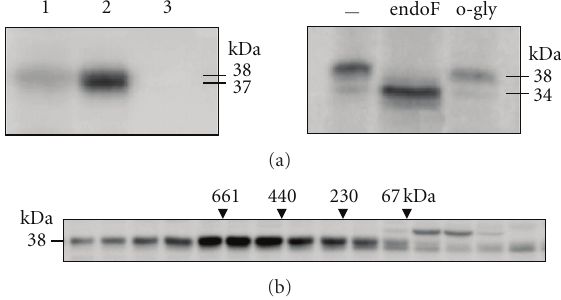
Figure 1: Characterization of FcnB in the mouse bone marrow. (a) Western blotting of FcnB in the supernatant (lane 1) and precipitate (lane 2) of bone marrow tissue, and plasma (lane 3) (left panel). Two μ L of the supernatant/precipitate equivalent to the original tissue and 2 μ L of plasma from FcnA − / − mice were subjected to western blotting under reducing conditions. FcnB in the supernatant (4 μ L equivalent to the original tissue) was treated with endoglycosidase F (endo F ) or neuraminidase plus endo- α -N- acetylgalactosaminidase ( o -gly) and subjected to western blotting (right panel).—, not treated. (b) Superose 6 gel chromatography of FcnB in the bone marrow supernatant from FcnA − / − mice. An aliquot of each fraction was subjected to western blotting under reducing conditions. Arrowheads depict the eluted positions of the molecular weight markers (661kDa, thyroglobulin; 440 kDa, ferritin; 230 kDa, catalase; 67kDa,